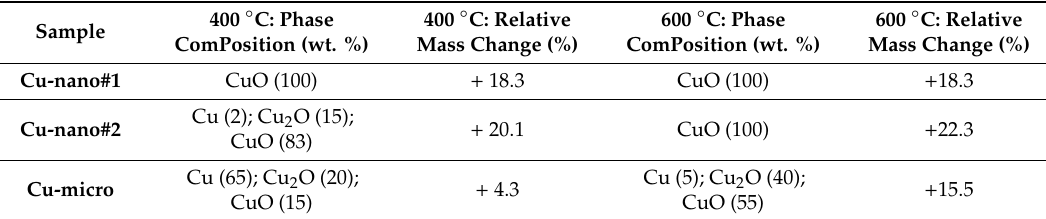
Table 2. Results of STA (final temperature 400 or 600 ◦ C), phase composition was obtained by Rietveld analysis.